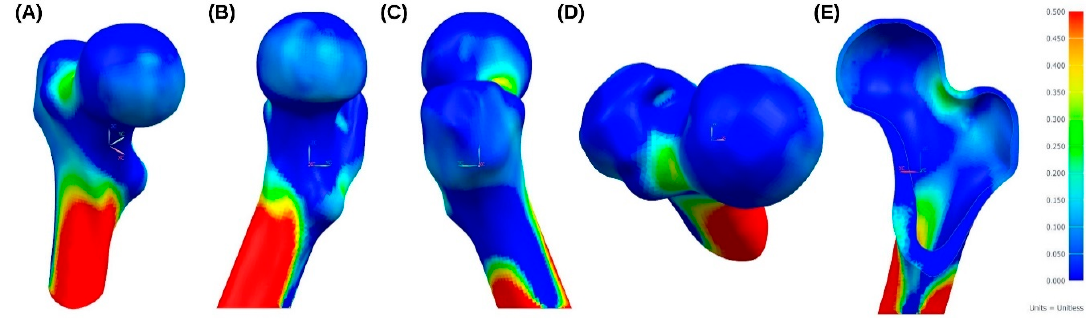
Figure 15. ( A ) Isometric, ( B ) right, ( C ) left, ( D ) top and ( E ) back view of Tsai–Wu field in proximal femur when applying standing-up loads.